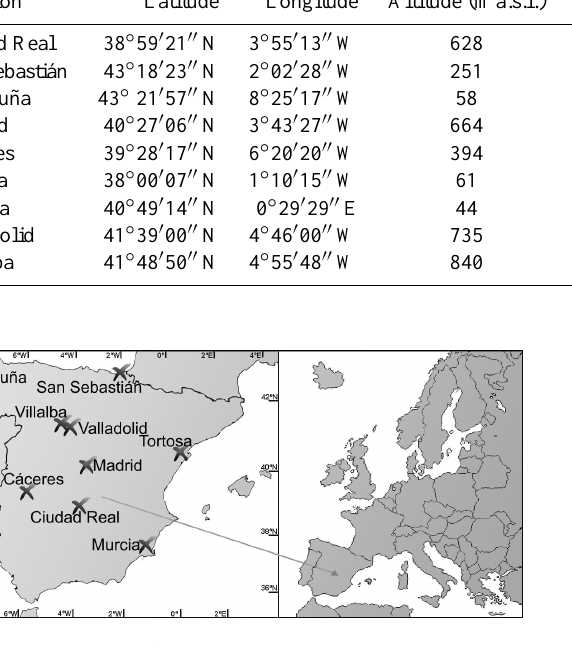
Figure 1. Distribution of selected Spanish stations located in the Iberian